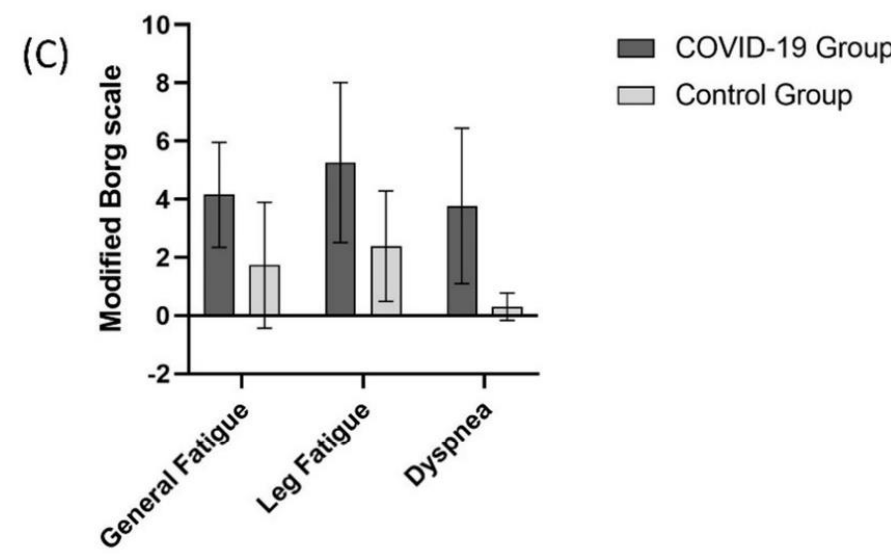
Figure 2. Comparison of ( A ) 6 minute walk test (6MWT) distance ( p < 0.001), ( B ) oxygen saturation (SpO 2 ) after 6MWT ( p < 0.001), ( C ) general fatigue (Borg) ( p < 0.001), leg fatigue (Borg) ( p < 0.001), and dyspnea (Borg) ( p < 0.001) scores between the COVID-19 and control groups.